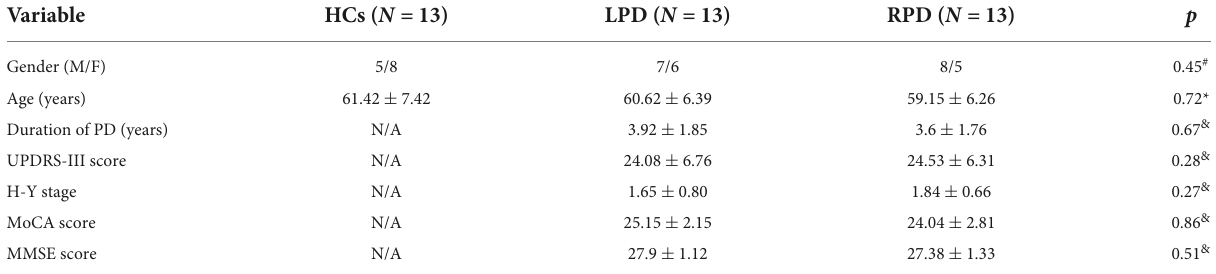
TABLE 1 Demographics and clinical data.